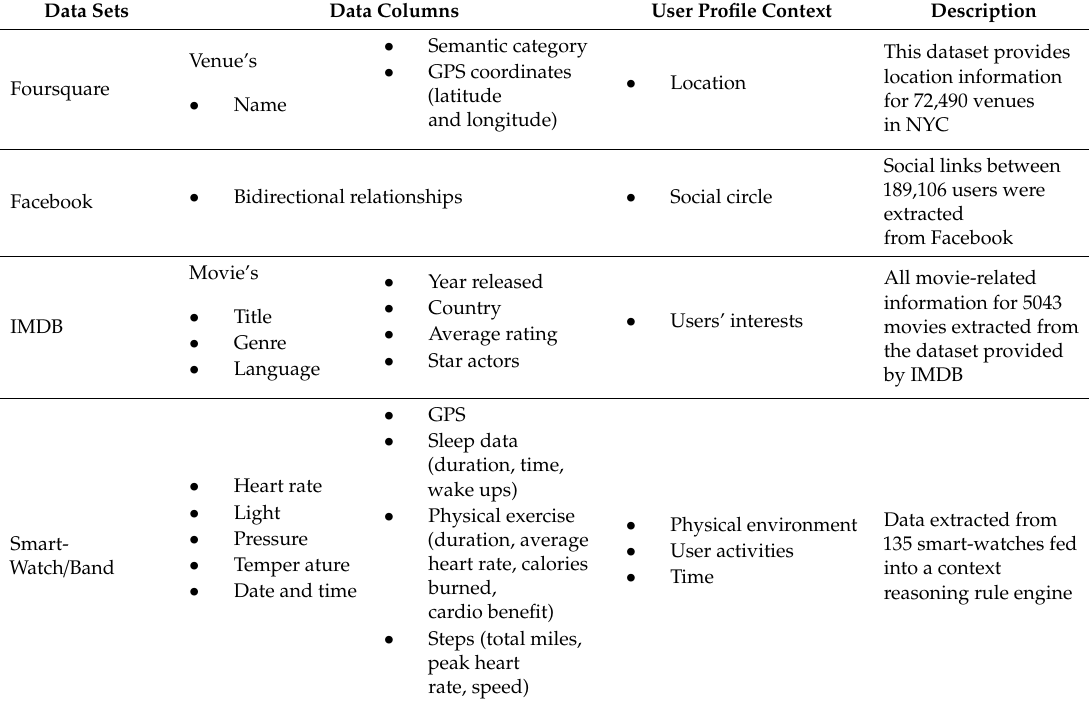
Table 7. List of di ff erent data sources applied in this